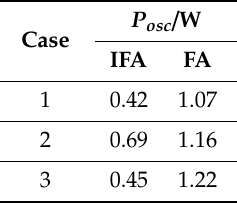
Table 4. Average power oscillation interval of FA and IFA.